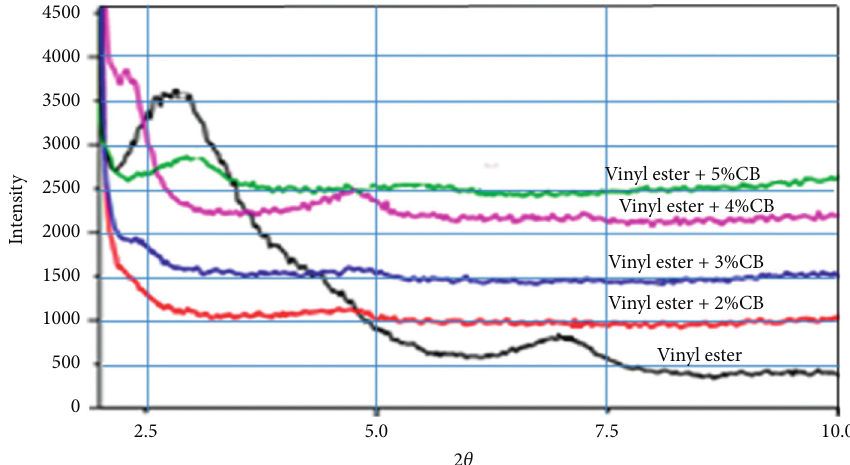
Figure 1: XRD pattern for vinyl ester and its composites.